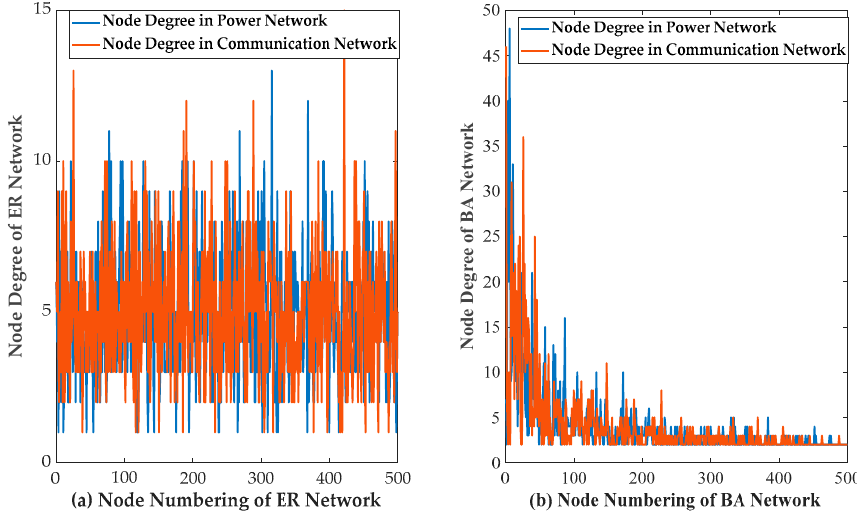
Figure 9. Comparison of node degree distribution in the CN and PN.